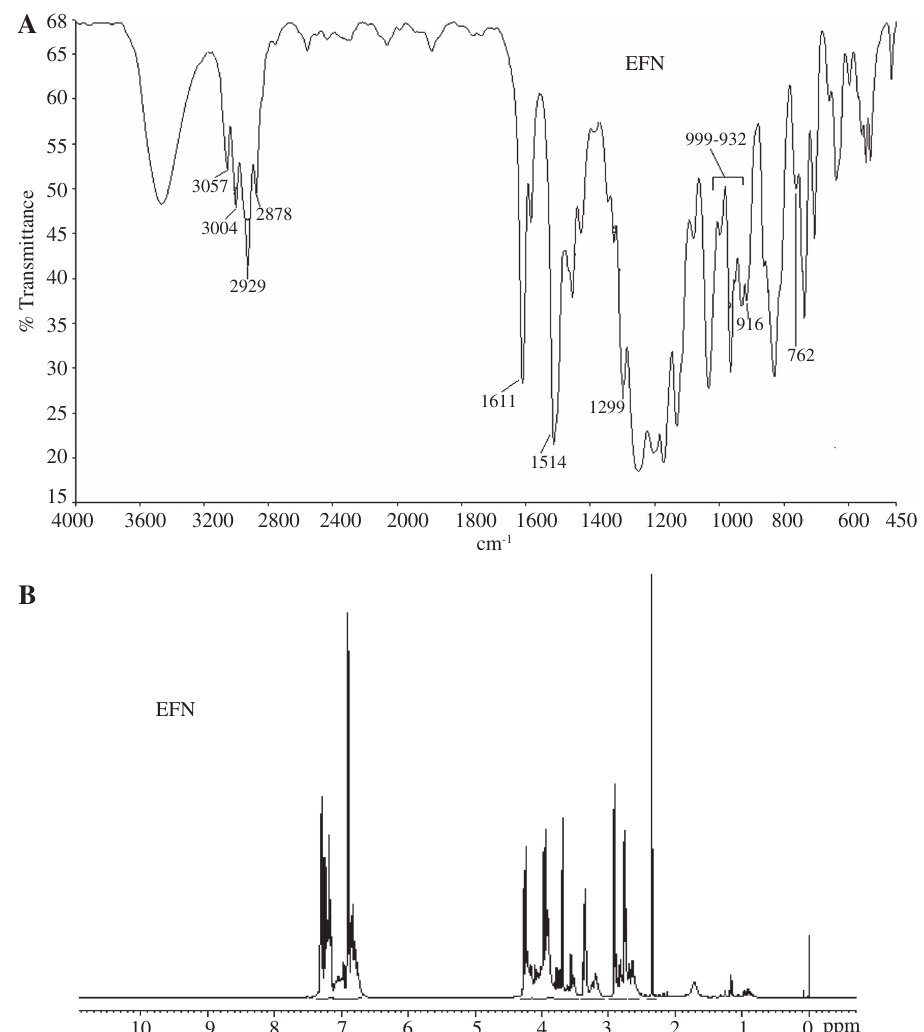
Figure 1: (A) FTIR and (B) 1 H NMR spectra of EFN,